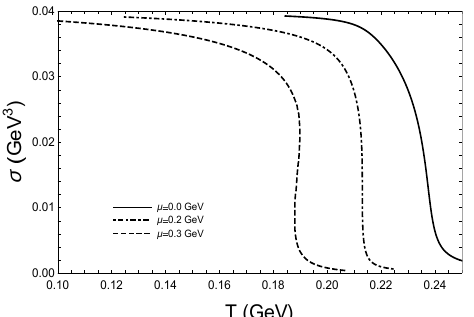
Figure 8. The chiral condensate (cid:27) as a function of the temperature T for three di(cid:11)erent quark chemical potentials (cid:22) . The solid line is for (cid:22) = 0 GeV, the dashed-dotted line is for (cid:22) = 0 : 2 GeV and the dashed line is for (cid:22) = 0 : 3 GeV, respectively. The crossover becomes (cid:12)rst order transition at high chemical